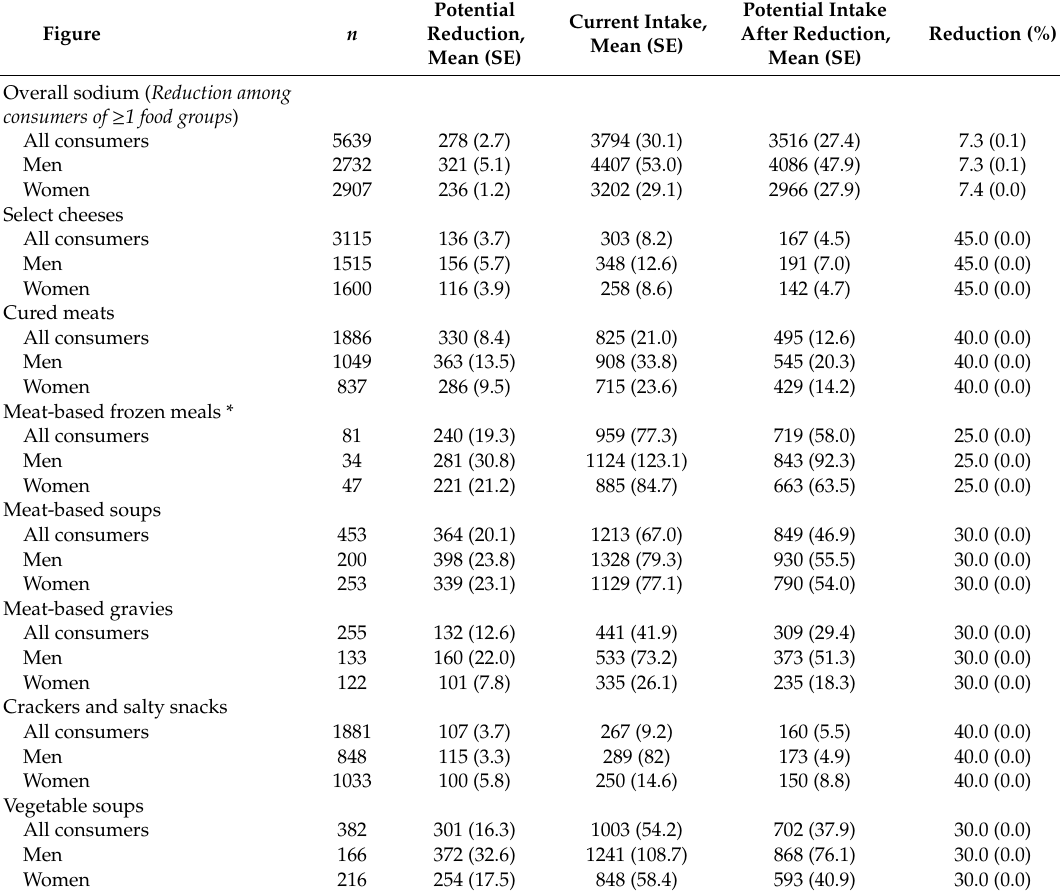
Table 6. Potential sodium intake reduction with MSG in the diets of U.S. adults (aged ≥ 19 years)